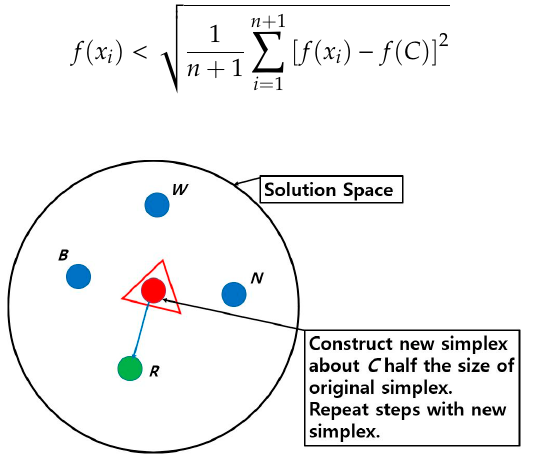
Figure 2. The Nelder–Mead simplex method process [18].